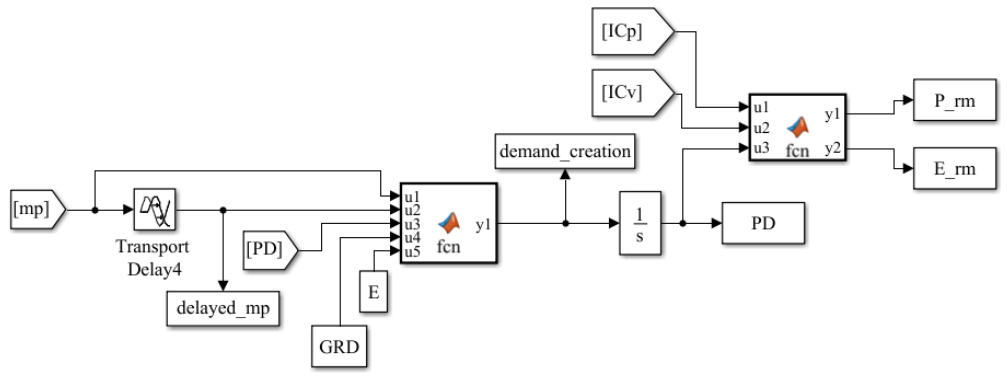
Figure A2. Demand component.